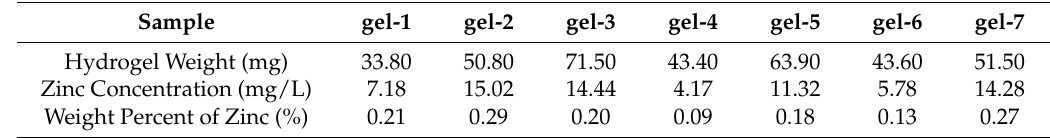
Table 2. Zinc content in the different hydrogels.